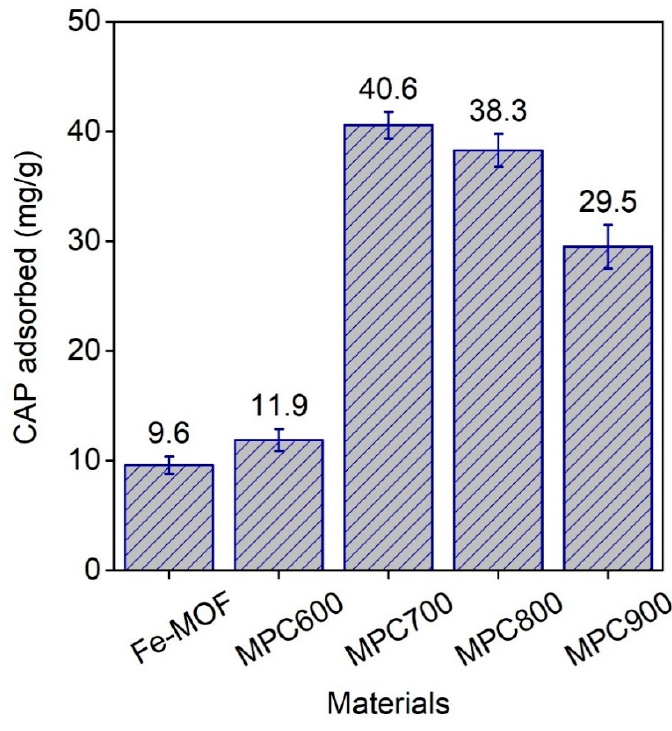
Figure 5. Comparative adsorption capacities of CAP antibiotic onto materials Fe 3 O(BDC) 3 and MPCs- x , where x presents pyrolysis temperature at 600, 700, 800, and 900 °C .